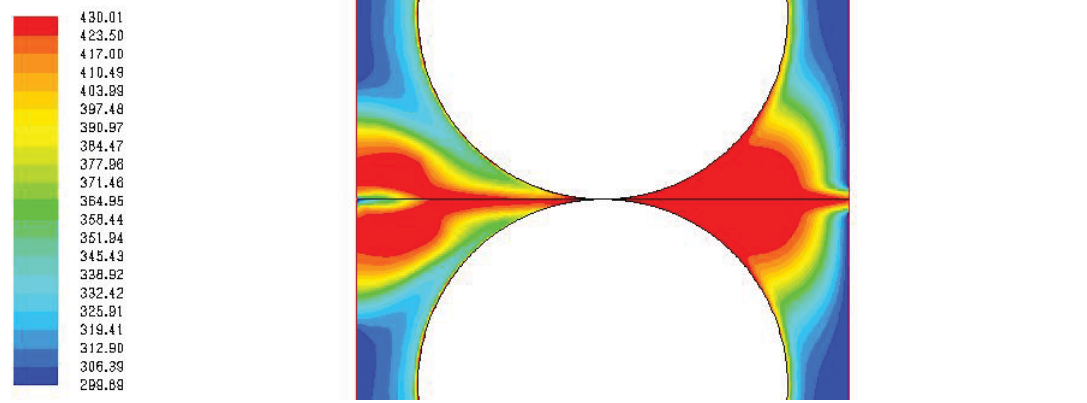
Figure 3: Temperature field between the drums